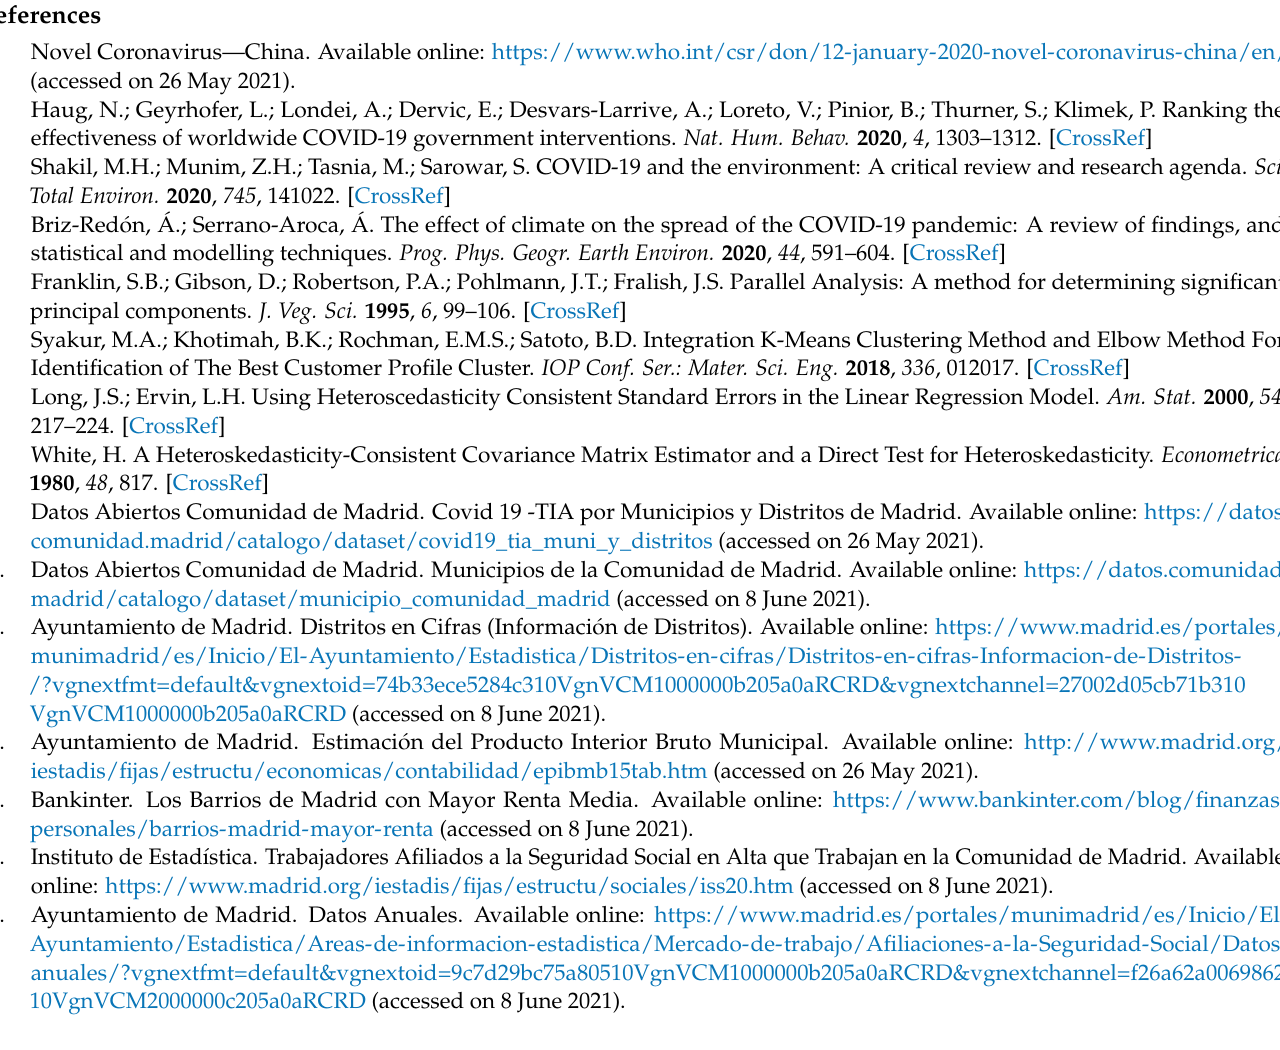
Figure A1. Scree plot for the selection of clusters.